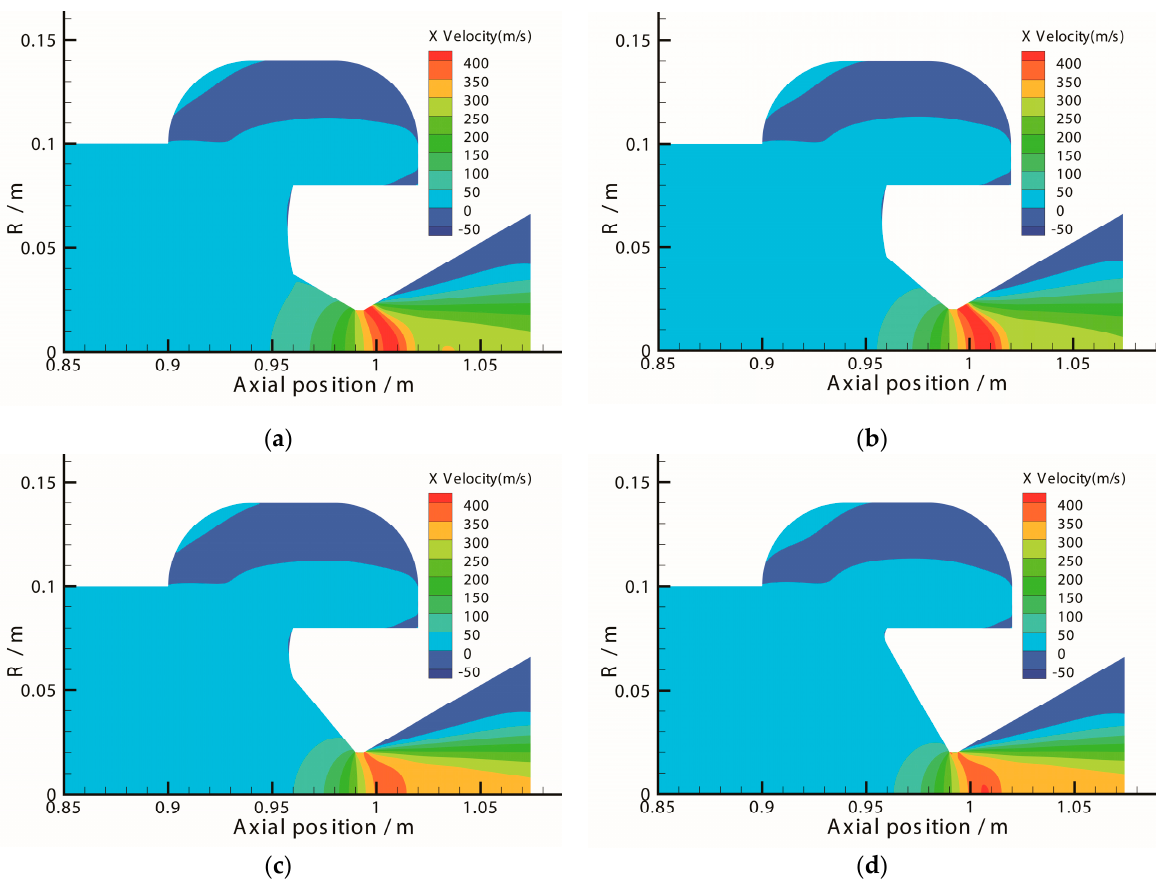
Figure 12. The axial velocity contour under different convergent angle. ( a ) Convergent angle of 30 degrees. ( b ) Convergent angle of 40 degrees. ( c ) Convergent angle of 50 degrees. ( d ) Convergent angle of 60 degrees.